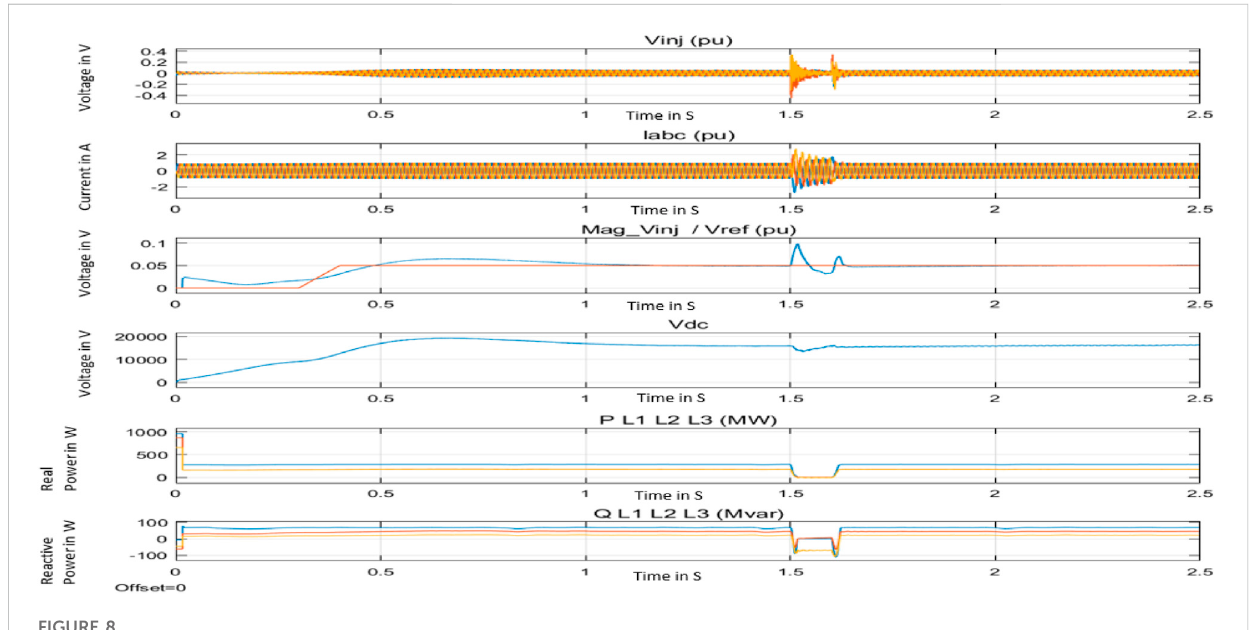
FIGURE 8 TLBO-PI controller results after connecting the SSSC.